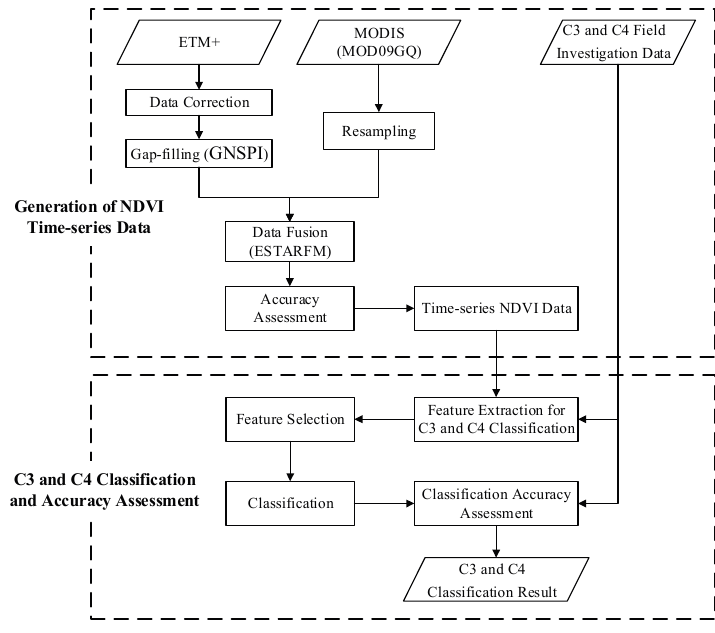
Figure 2. Flowchart of the C3 and C4 vegetation classification